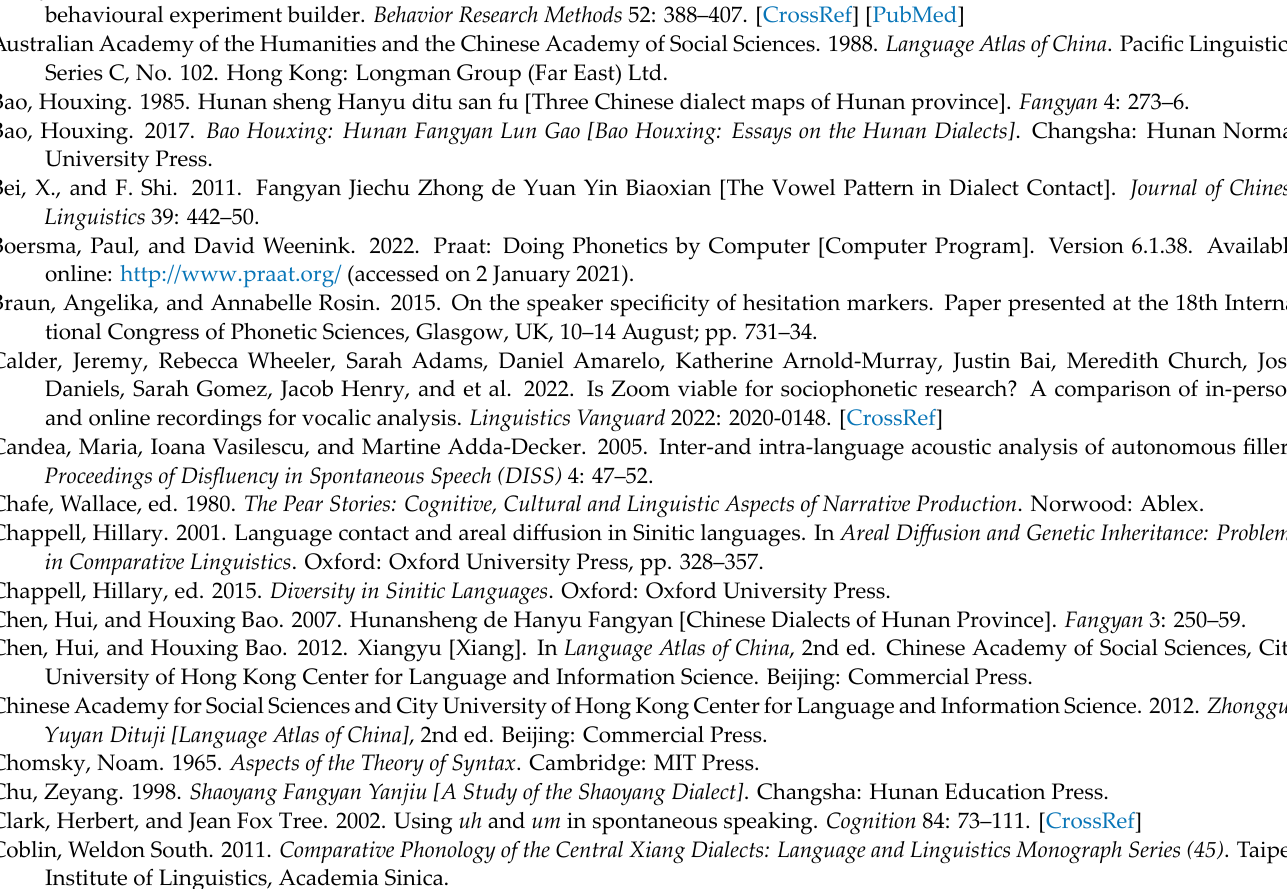
Figure 6, Figure 7 and all statistical analysis conducted using R (R Core Team 2022). 13. Standard deviation can be observed in Figure 6 as the dark gray shaded areas above and below the contour lines. 14. All figures from this point created with Norm (Thomas and Kendall 2007).